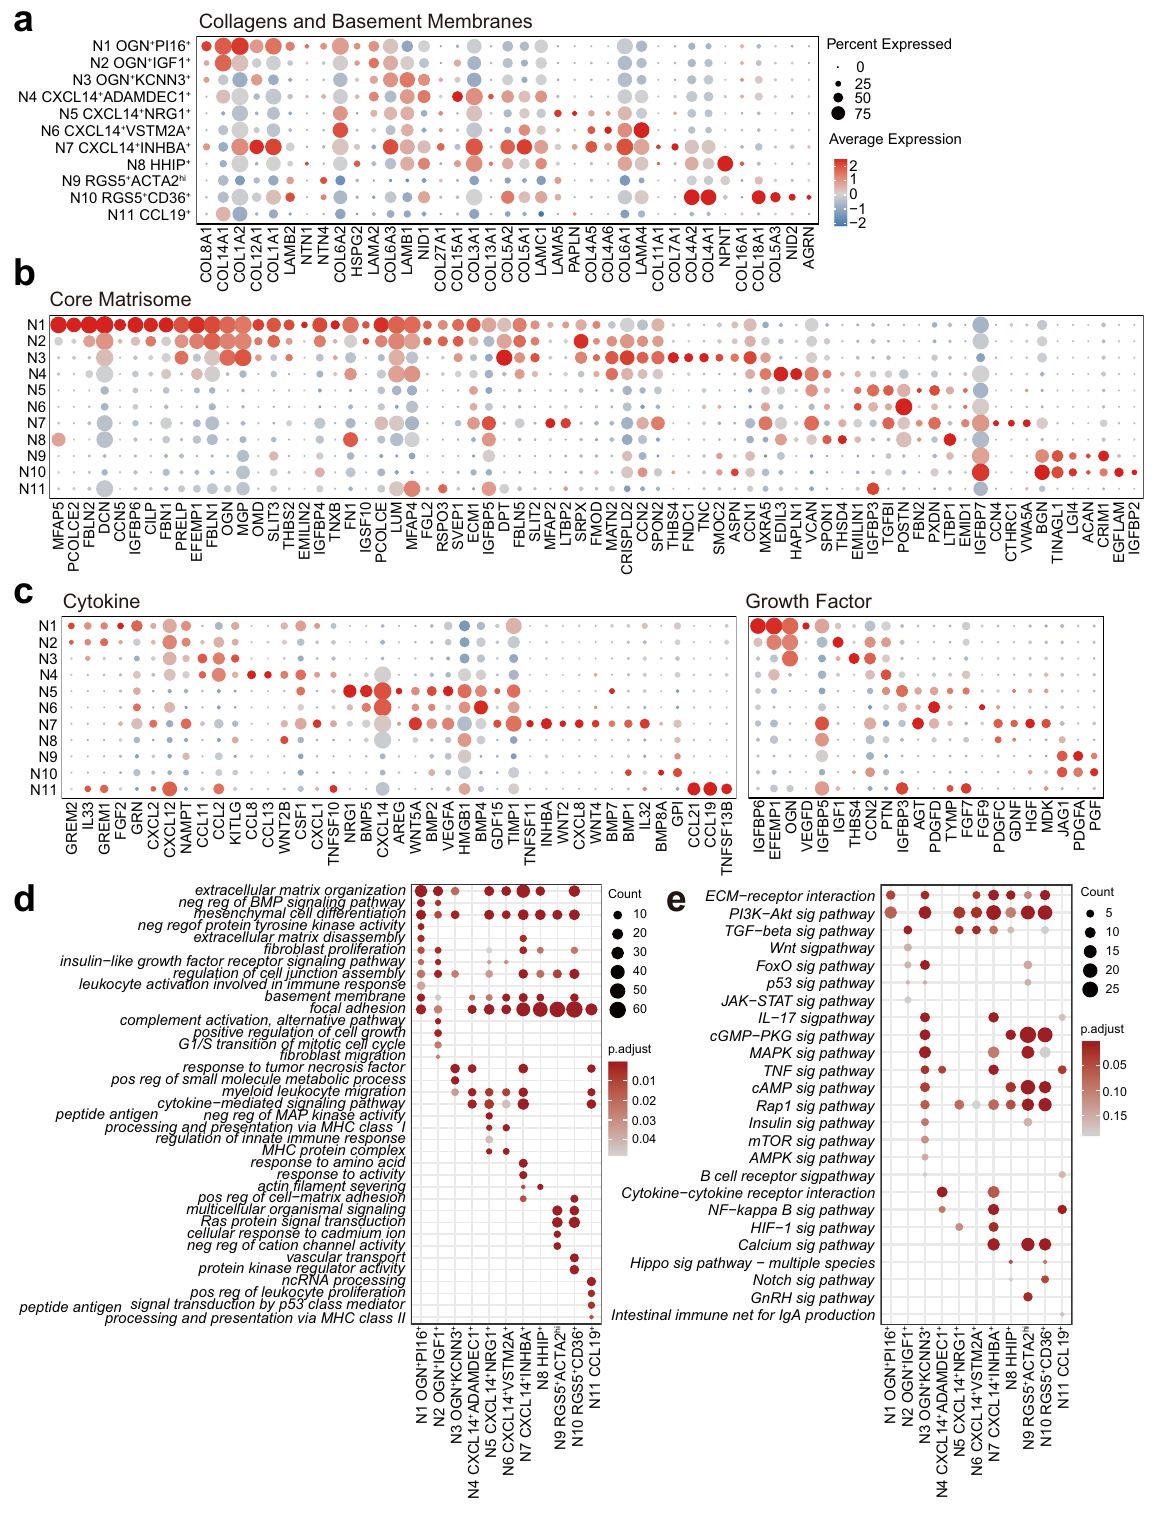
(Fig. 2d, e). Taken together, these data represent a comprehen- sive, high-quality dataset demonstrating the cell diversity of fi broblasts and myo fi broblasts in human colon mucosa. Population connectivity of fi broblasts and myo fi broblasts in human colon mucosa . The transcriptome expression data obtained from the large number of fi broblasts and myo fi broblasts